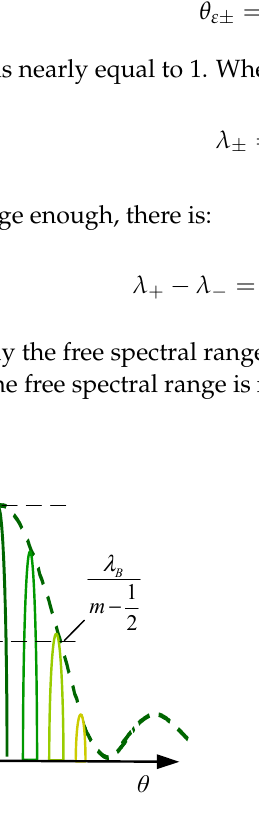
Figure 2. The BF function schematic of the echelle at order m.